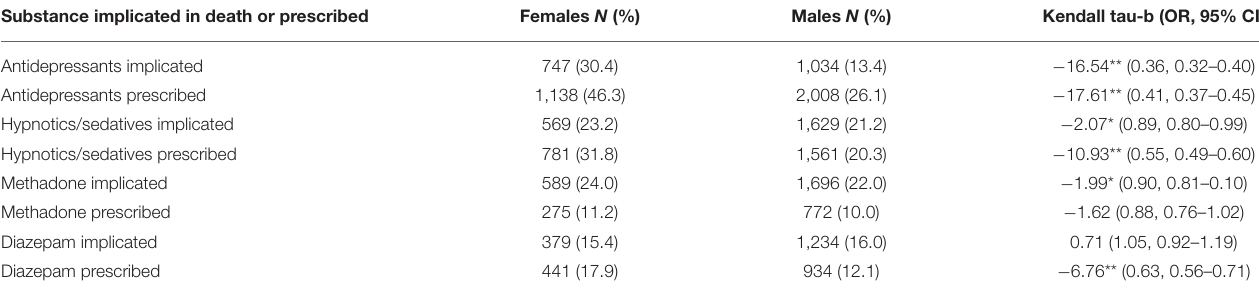
TABLE 3 | Whole cohort, substances implicated and prescribed by gender †